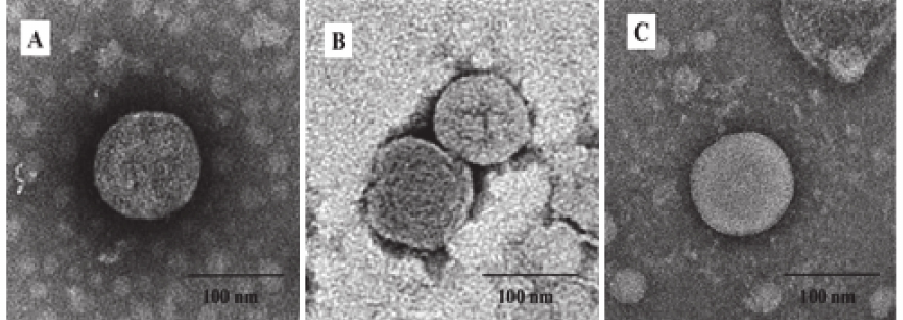
Figure 4. The formation of infectious bronchitis virus (IBV) VLPs identified by TEM. ( A ) Purified SME-VLPs. ( B ) Purified SM-VLPs. ( C ) Purified ME-VLPs. Bar = 100 nm.